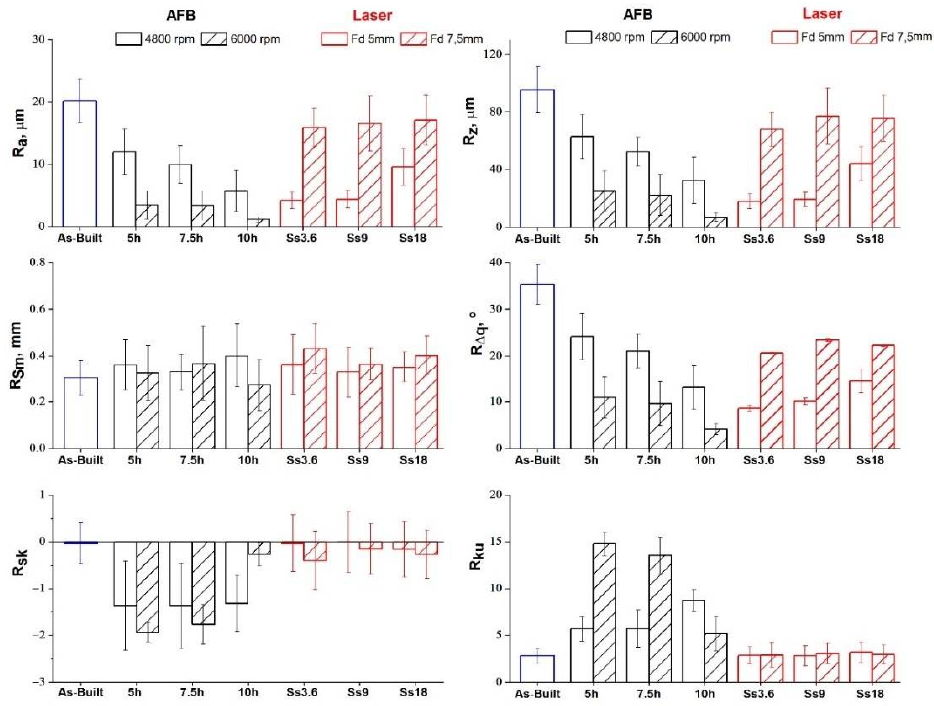
Figure 6. Roughness parameters of the as-built sample and treated ones for different process conditions. To relate the evolution of morphology, in particular, the regression of the re-solidified metal droplets in Figure 5a by the action of abrasive or laser source, to material removal, the variation of sample dimensions was evaluated and shown in Figure 7. The variation of the diameter can be compared to Rz to understand if the removal of partially melted particles was completed during the finishing processes. Both the treatments determined the removal of semi-molten powder agglomerates, typical of additively manufactured parts.